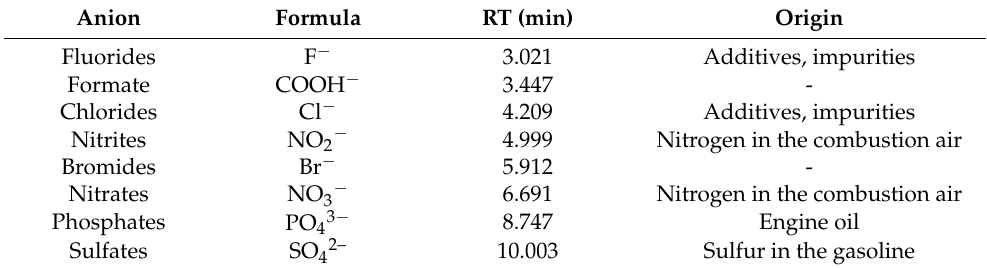
Table 6. Anions reported in this study and their formulas, retention times for IC analysis, and origins. Anion Formula RT